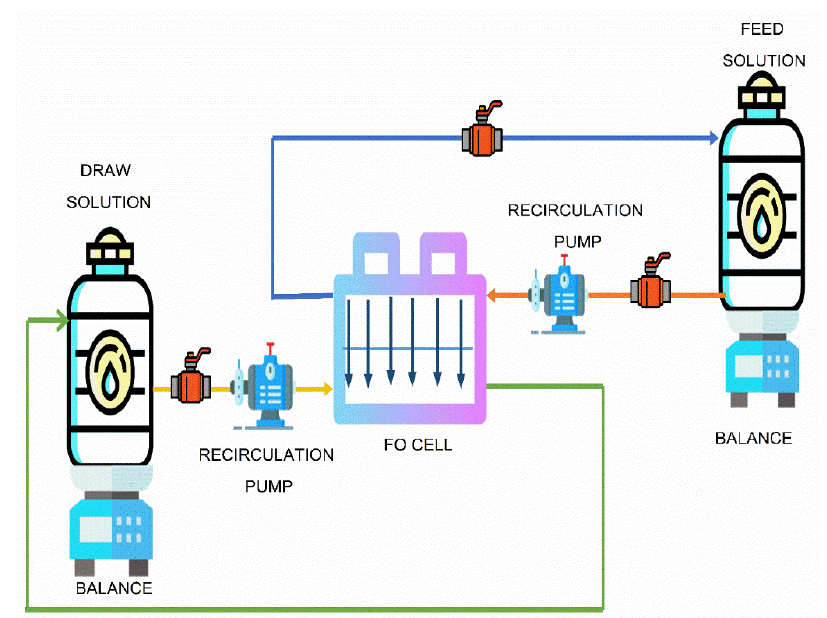
Figure 3. Diagrammatic representation of the FO